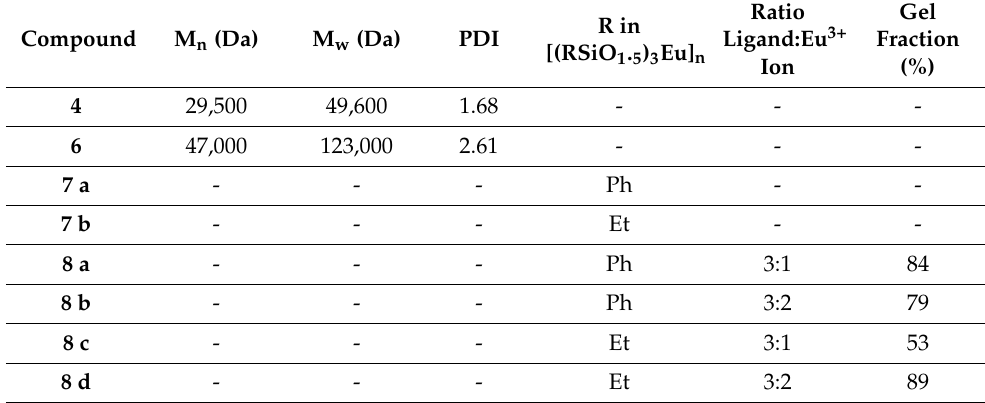
Table 1. Physicochemical properties of cross-linked polymers and